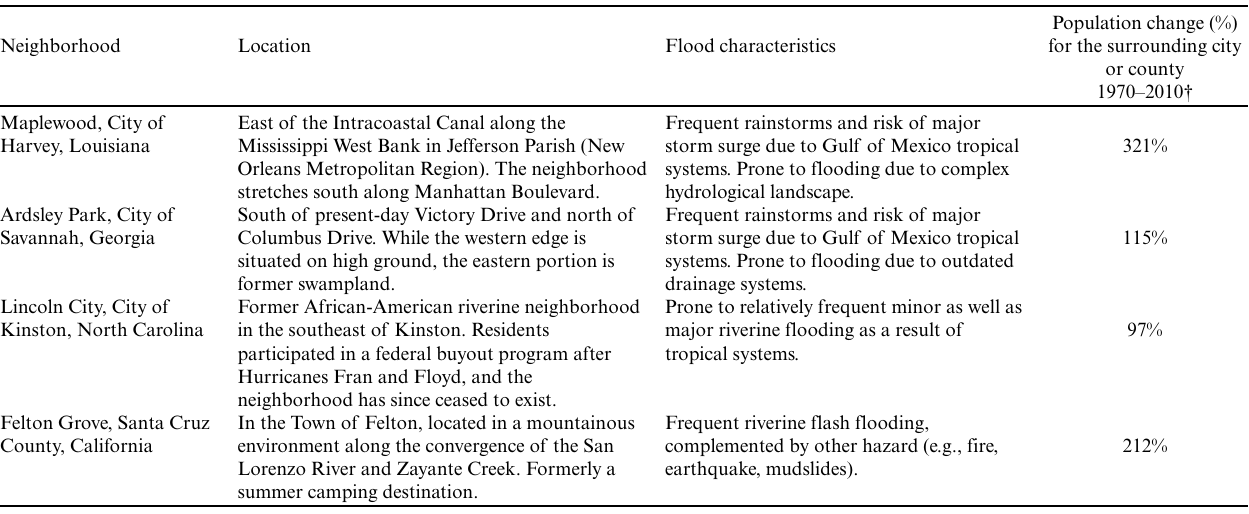
Table 2 . Field sites with flood characterizations